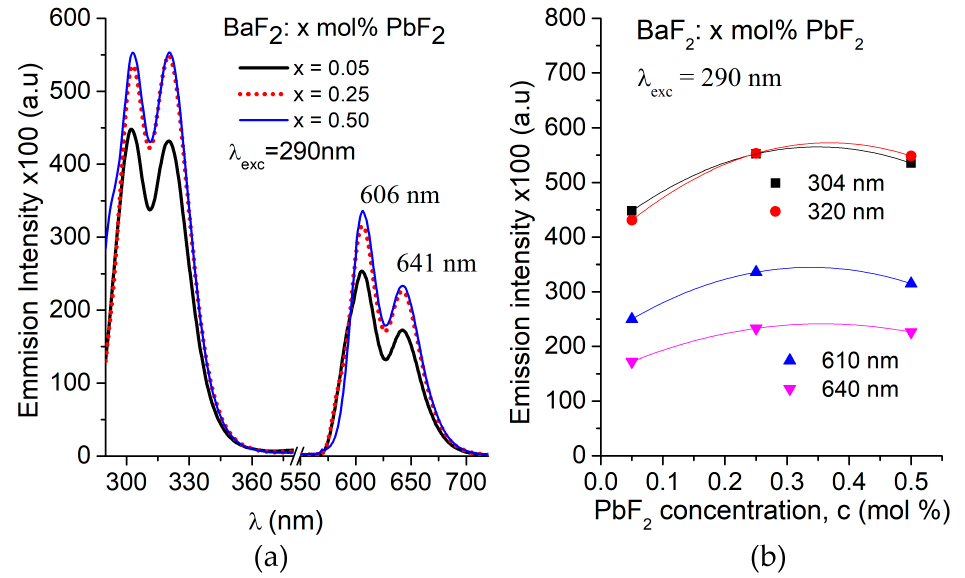
Figure 9. ( a ) Emission spectra of the studied samples under excitation in A band (290 nm); ( b ) dependence of the emission intensities on the PbF 2 concentration for the emission in the UV domain and the visible domain.